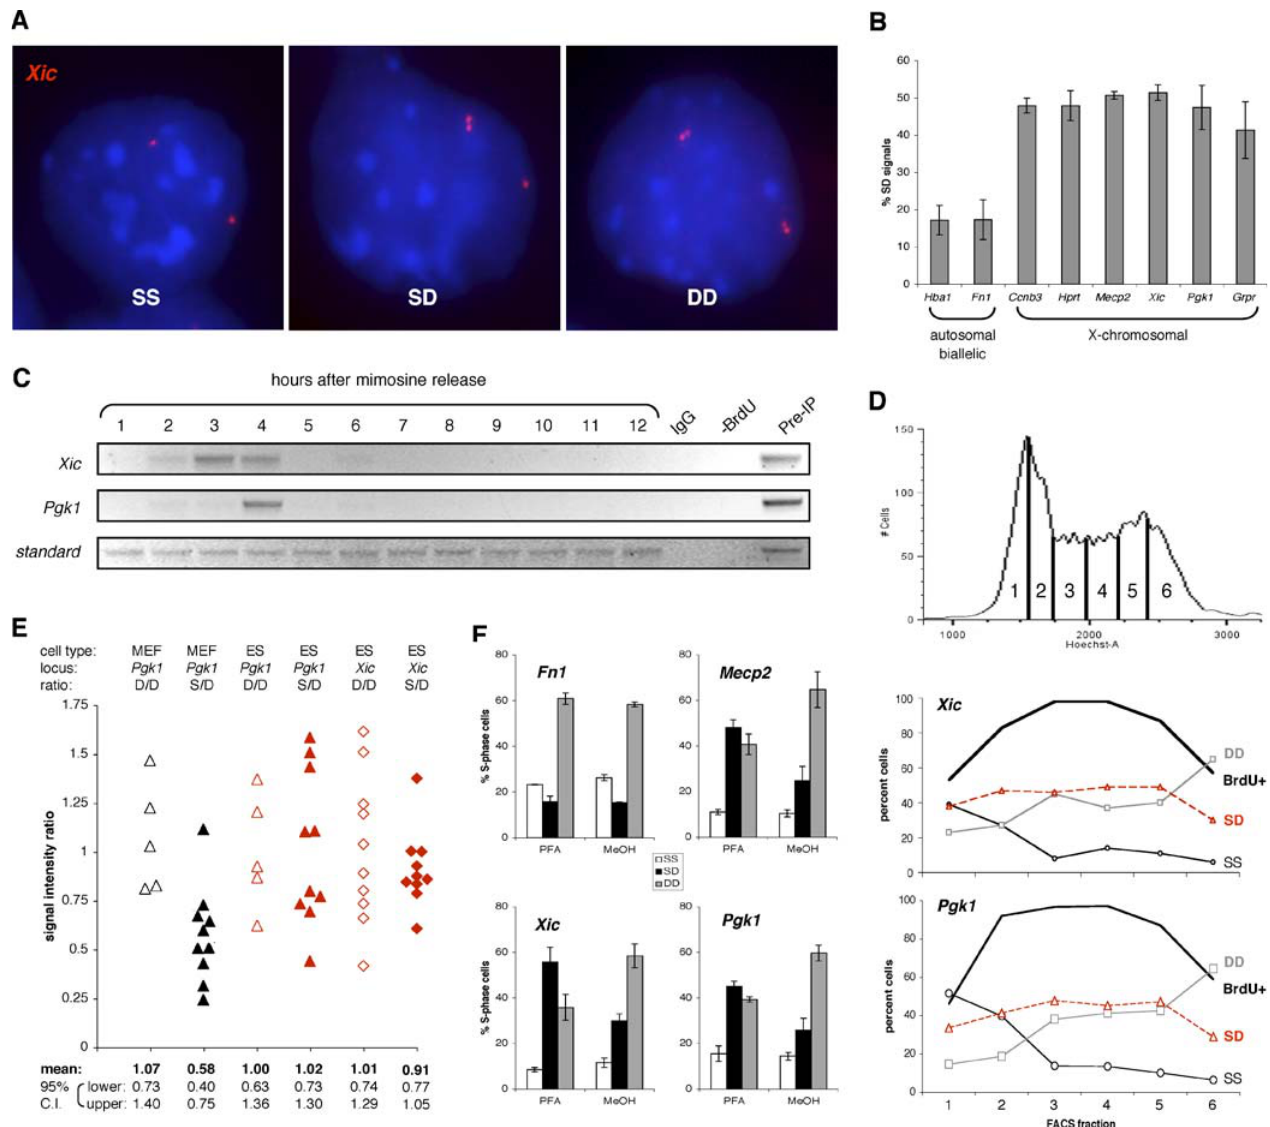
Figure 1. X-Chromosomal Loci Display SD FISH Signals Independent of Asynchronous DNA Replication (A) FISH for Xic genomic sequences (red) demonstrates the three classes of signals in PFA-fixed female ES cells. DNA was stained with DAPI (blue). (B) ES cells display an elevated proportion of SD signals at X-chromosomal loci. Average data from two to four experiments ( n . 150), scored by two independent scorers, are presented. Error bars indicate one standard deviation. See Figure S1A for complete scoring of SS, SD, and DD signals in these cells. (C) The Xic and Pgk1 show a single peak of replication in female ES cells. DNA was isolated from cells that were arrested in G1, released into S phase, and pulsed with BrdU at hourly intervals. Progression through S phase was monitored by FACS (Figure S1B). An equal amount of BrdU-labeled human DNA was added to each time point. BrdU-labeled DNA was immunopurified, and sequences present in each fraction were assessed by PCR. Standard shows amplification of a human sequence, as a control for variability in immunoprecipitations. IgG represents PCR analysis from labeled DNA purified with mouse IgG instead of anti-BrdU antiserum. –BrdU indicates analysis of an anti-BrdU immunoprecipitation from unlabeled DNA. Pre-IP depicts PCR analysis of the input DNA. (D) Live female ES cells, pulse-labeled with BrdU, were sorted into six fractions by Hoechst staining for DNA content (upper panel). FISH for the Xic (middle panel), and Pgk1 (lower panel) in these fractions shows constant, high proportions of SD signals (red triangles) throughout S-phase. Proportions of SS (black circles) and DD (gray squares) are also shown. The high proportion of BrdU-positive cells in all fractions (bold black line) shows that a substantial proportion of cells in all six fractions are in S phase. Over 80% of cycling ES cells are in S phase and fewer than 10% are in G1 [40], inevitably leading to the inclusion of early S phase cells in fraction 1. Data are representative of two or three independent experiments. (E) In ES cells, singlet and doublet FISH signals for X-chromosomal loci exhibit equivalent fluorescence intensity. Plots show the ratios of S/D (solid symbols) or D/D (open symbols) FISH signal intensities in individual MEF or ES cell nuclei displaying an SD or DD pattern for Pgk1 or the Xic as indicated. The intensity of both pinpoints in each doublet was summed to calculate the total intensity of doublet signals. When calculating the D/D intensity ratios, the two doublets in a cell were randomly assigned to the numerator or denominator. Mean ratio values and 95% confidence intervals for the means are indicated. (F) Comparison of the proportions of cells displaying SS (white), SD (black), and DD (gray) signals for an autosomal locus (Fn1) and three X-chromosomal loci (Mecp2, Xic, and Pgk1) in S-phase ES cells upon PFA or MeOH fixation. DOI: